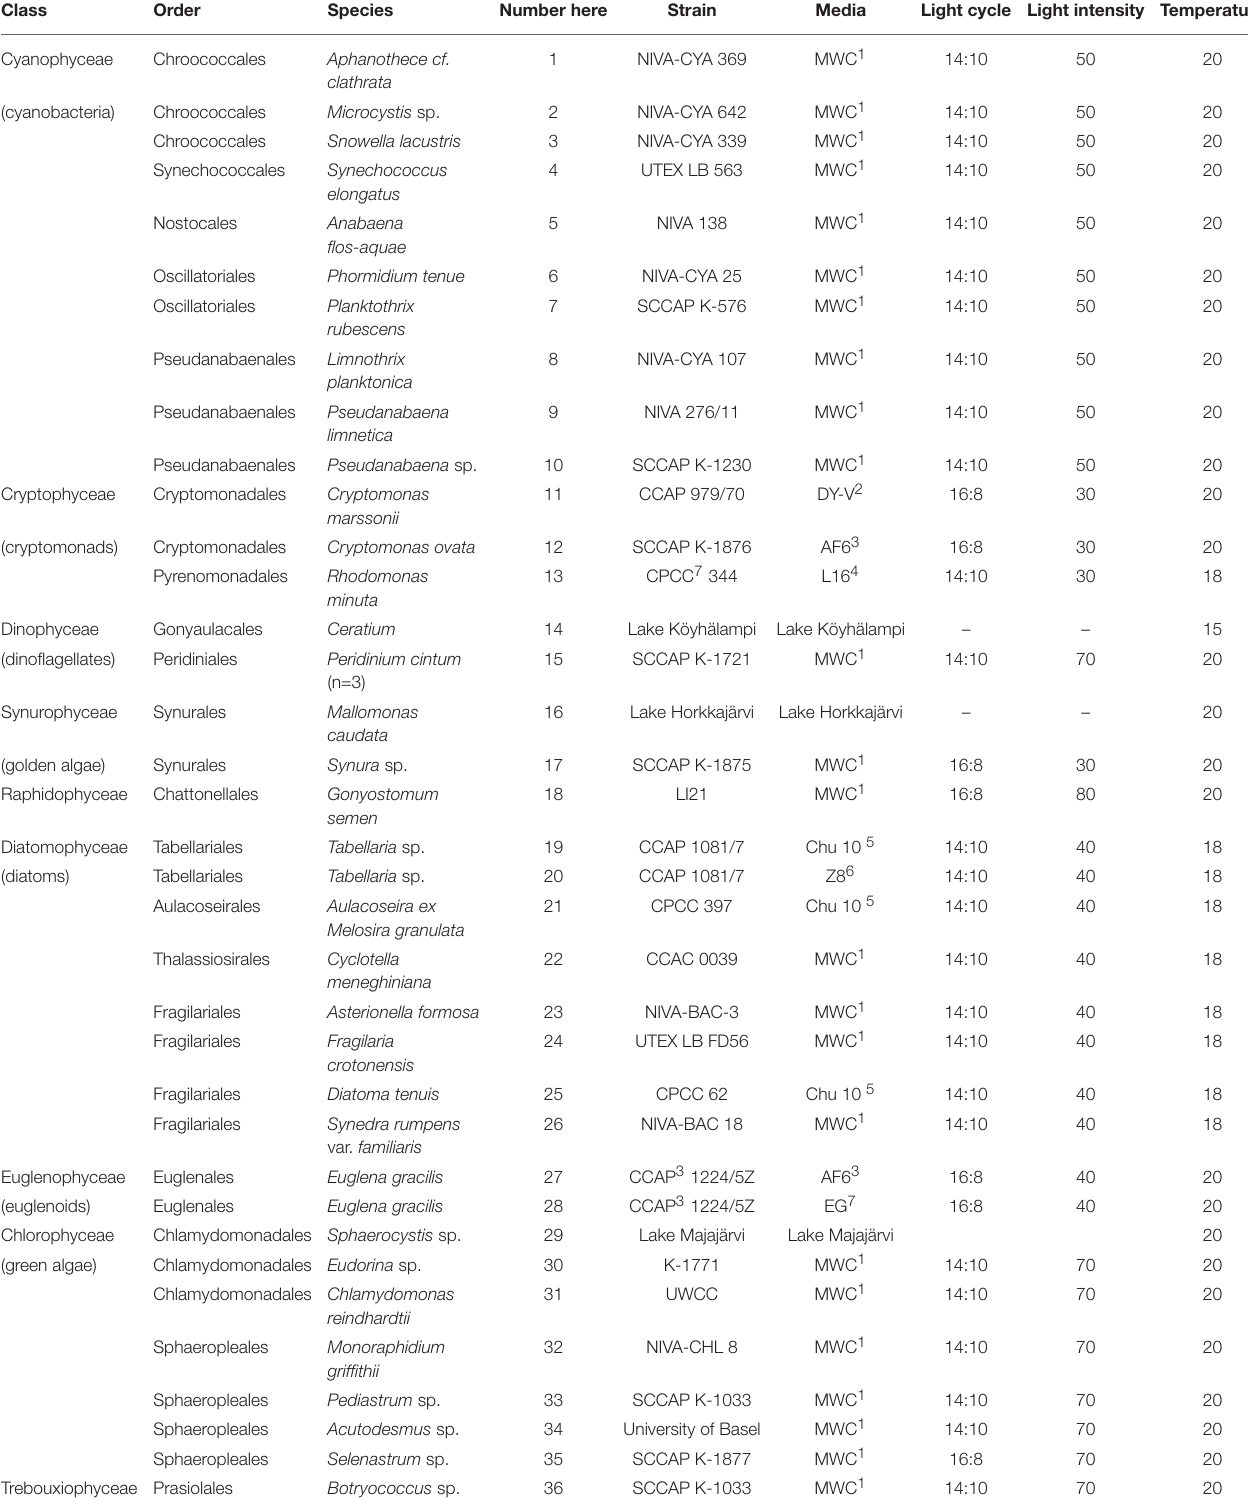
TABLE 3 | Class, order, species, and the strain code information of the studied freshwater phytoplankton.